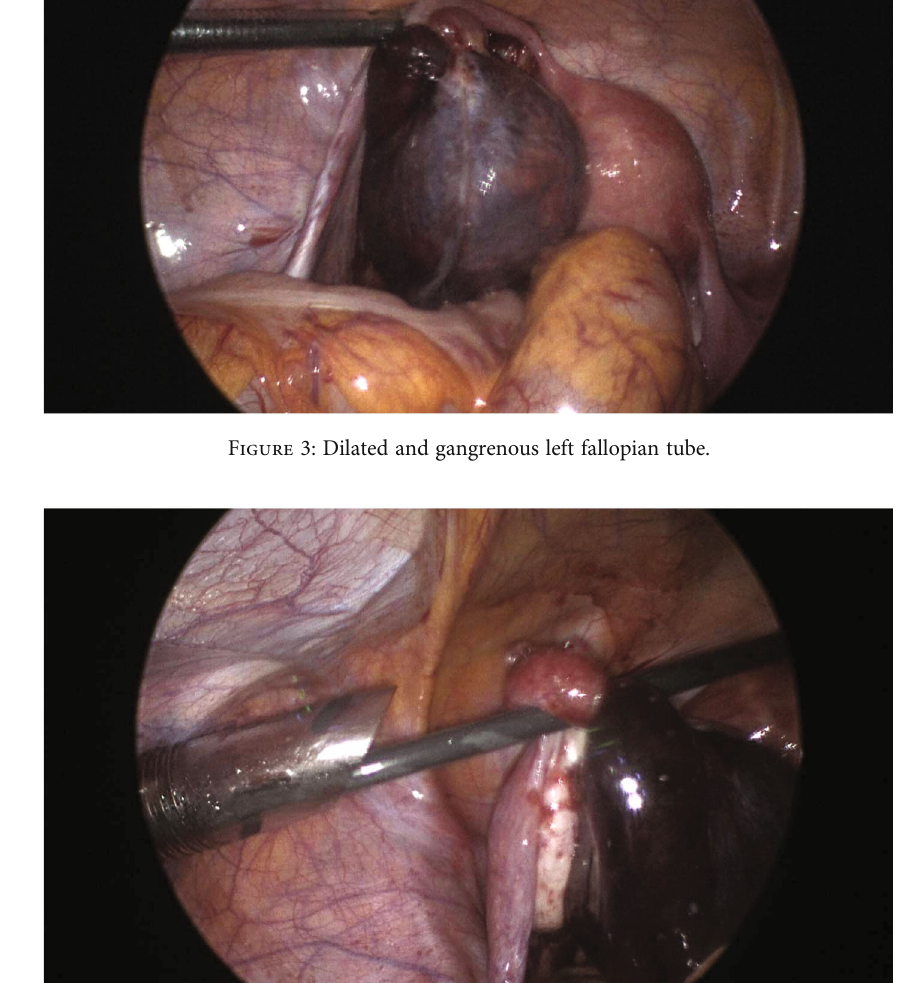
Figure 4: Torted fallopian tube with ipsilateral normal ovary.